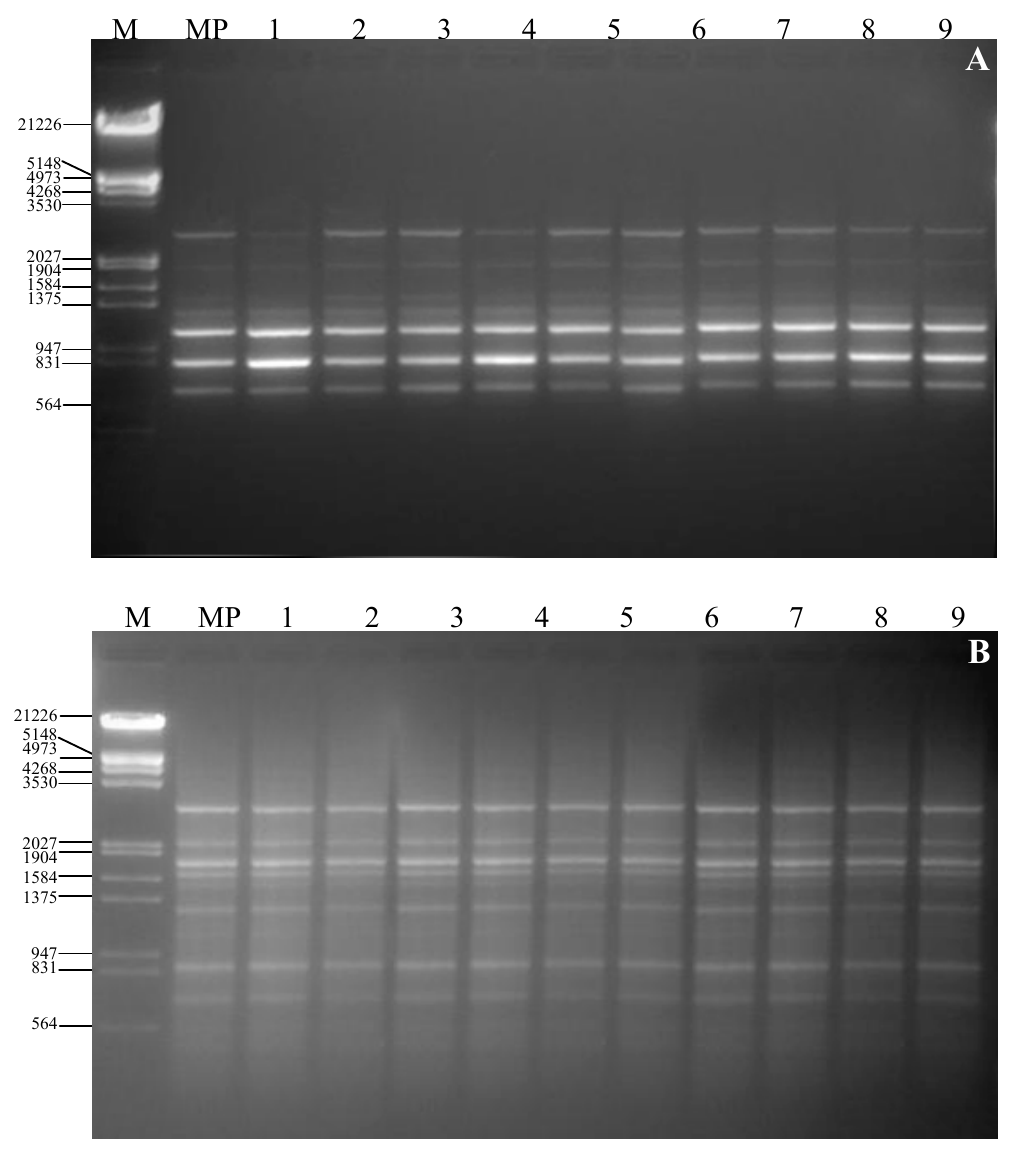
Figure 3. Agarose gel electrophoresis of RAPD and ISSR products of synseed-raised Rauvolfia serpentina plantlets and mother line obtained with primer OPA-11 (A) and ISSR-03 (B). Lanes 1–9, regenerants; Lane MP=mother plant; lane M = Lambda DNA/Eco RI + HindIII marker indicated in